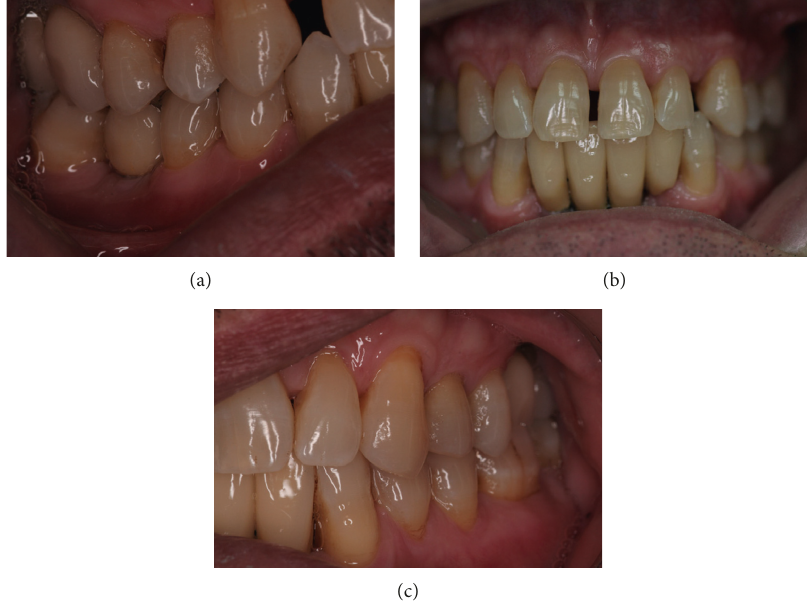
Figure 8: Clinical photos 12 years after periodontal surgery and 10 years after final implant